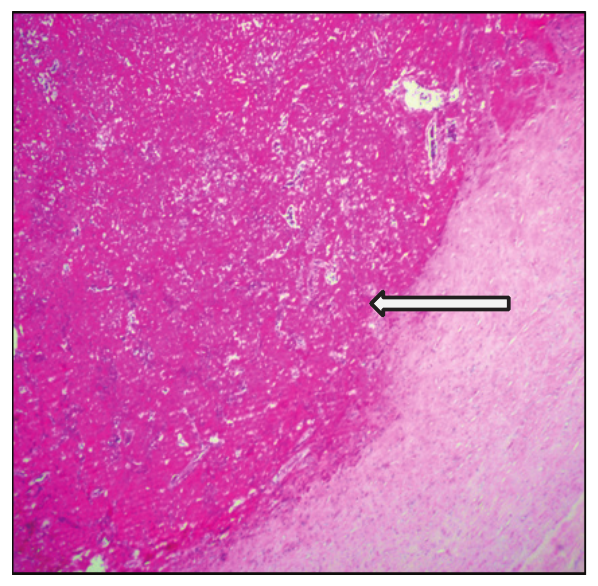
FIGURE 5: Haematoxylin and eosin (H&E) photomicrograph at higher magnification (40×) of the organising fibrin deposition showing an amorphous coagulum of acellular fibrin.